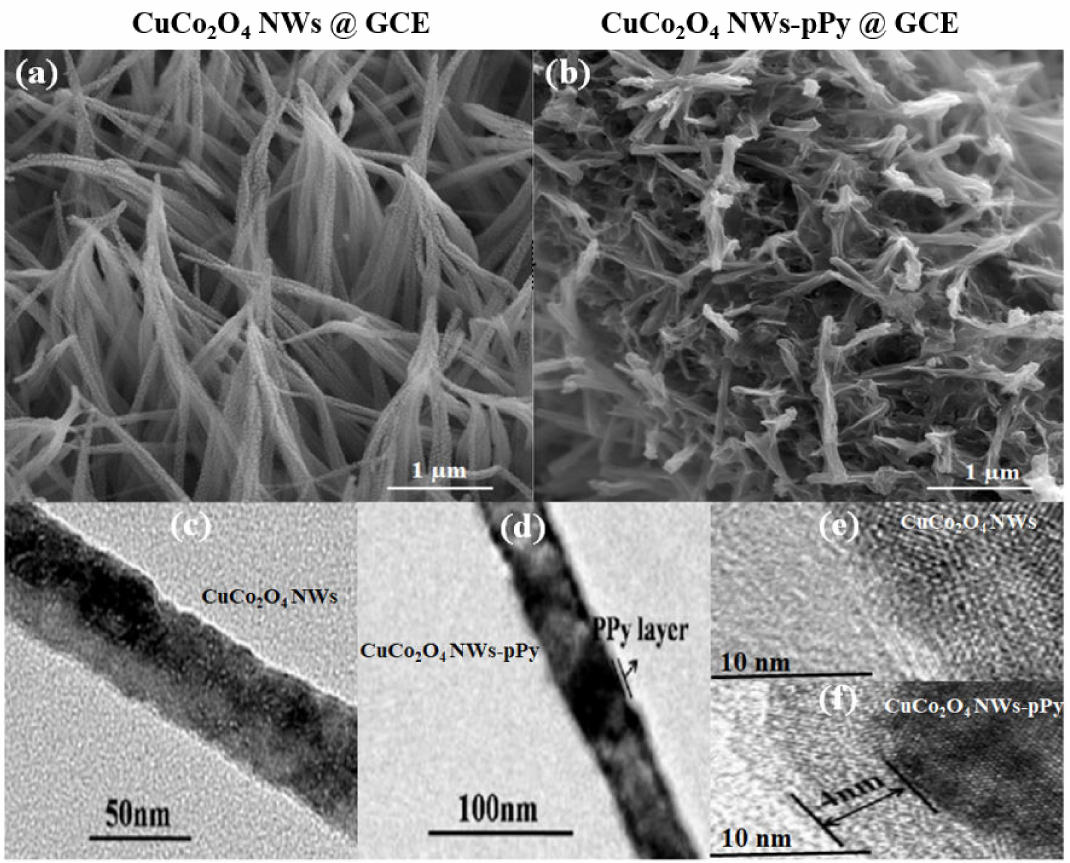
Figure 1. The FESEM images of as-synthesized ( a ) CuCo 2 O 4 NWs@CCE and ( b ) CuCo 2 O 4 NWs-pPy@CCE. The TEM images of as-synthesized ( c ) CuCo 2 O 4 NWs and ( d ) CuCo 2 O 4 NWs-pPy. The HRTEM images of as-synthesized ( e ) CuCo 2 O 4 NWs and ( f ) CuCo 2 O 4